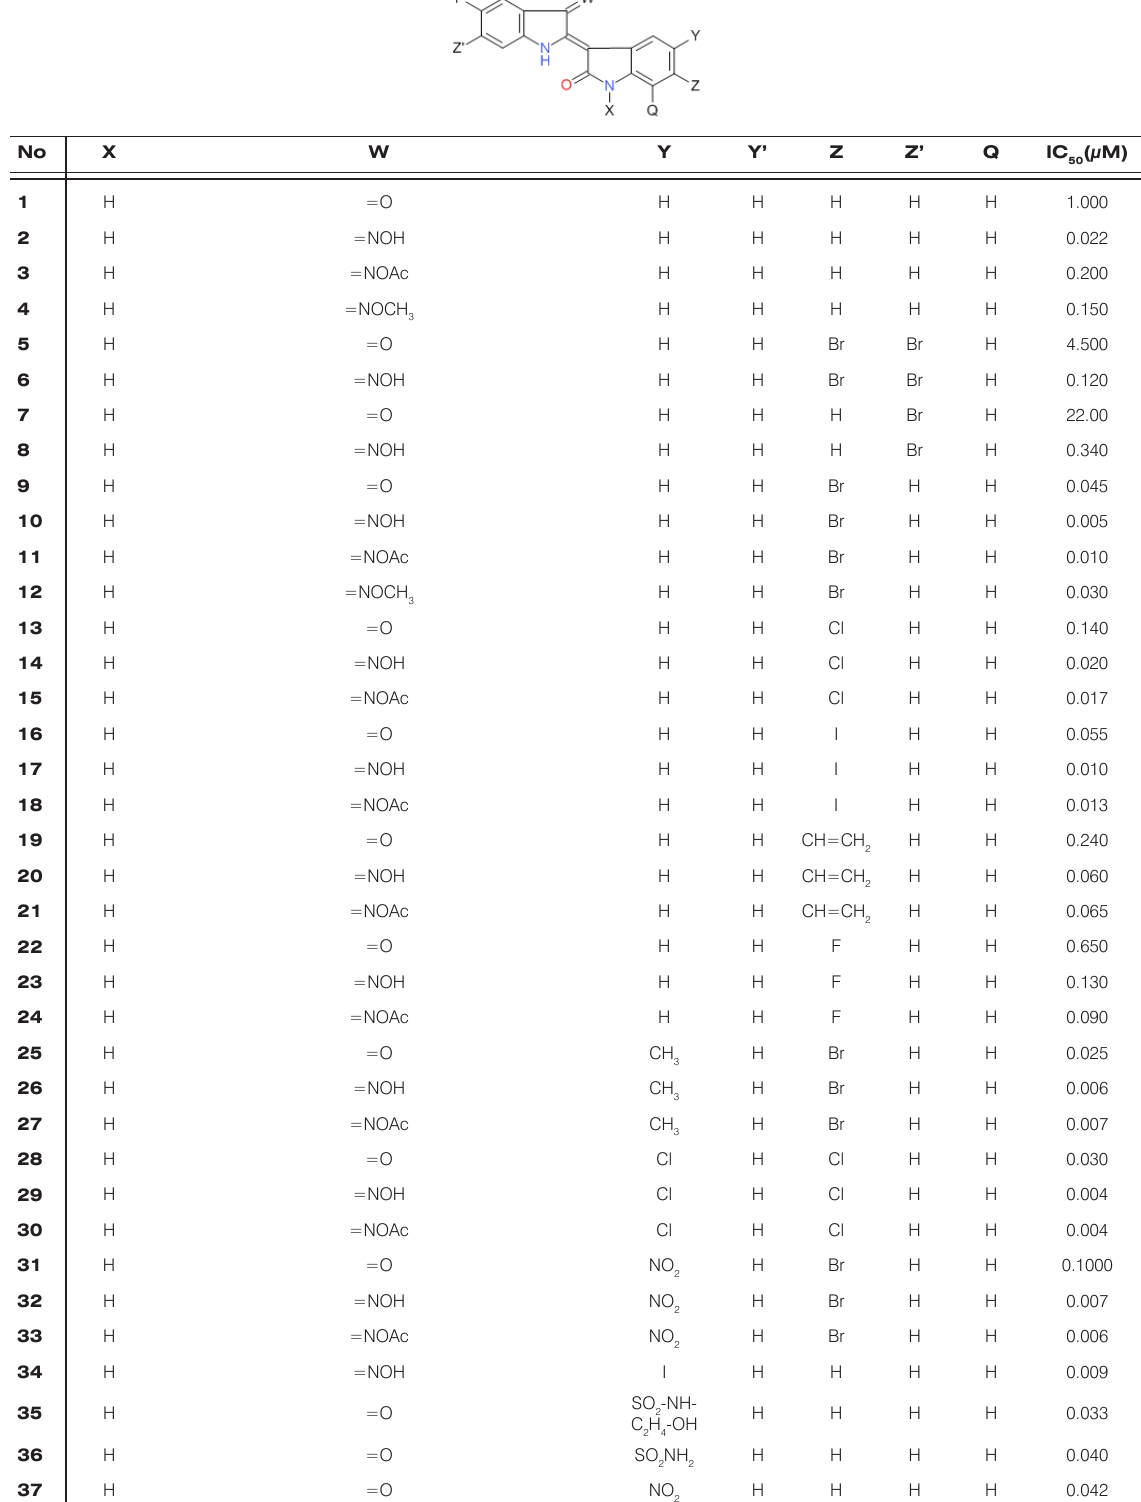
) of indirubin 50